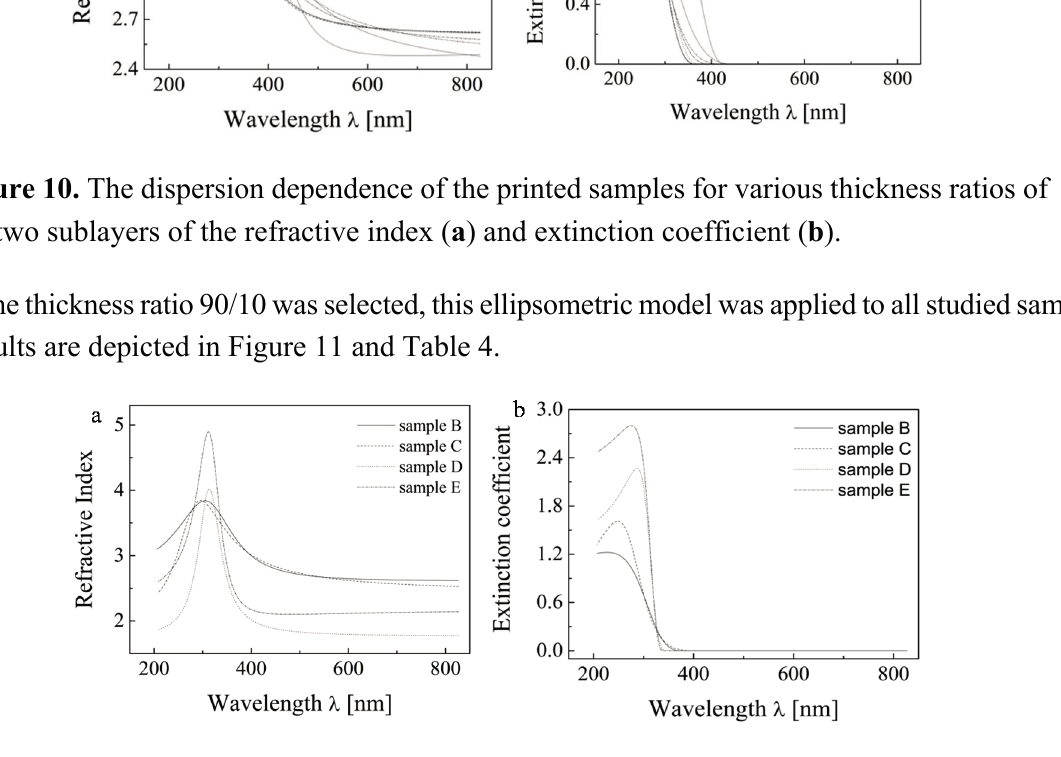
Figure 11. The final computed refractive index ( a ) and extinction coefficient ( b ) values for studied samples on their first layer. Table 4. Properties refractive index of prepared materials TiO 2 by sol-gel method at 590 nm